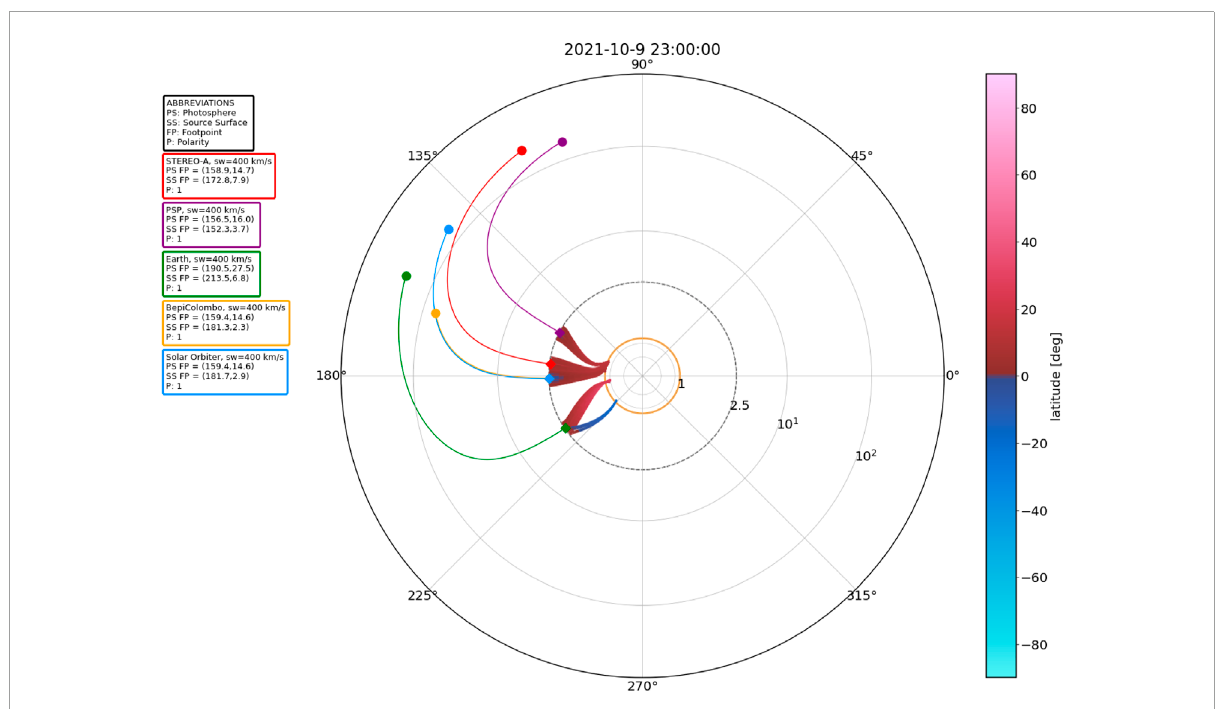
FIGURE 3 PFSS backmapping output of Solar-MACH for the SEP event on 9 October 2021. Note the different scaling of the radial axis compared to Figure 2 (see text for details). The yellow circle represents the photosphere at one solar radius.